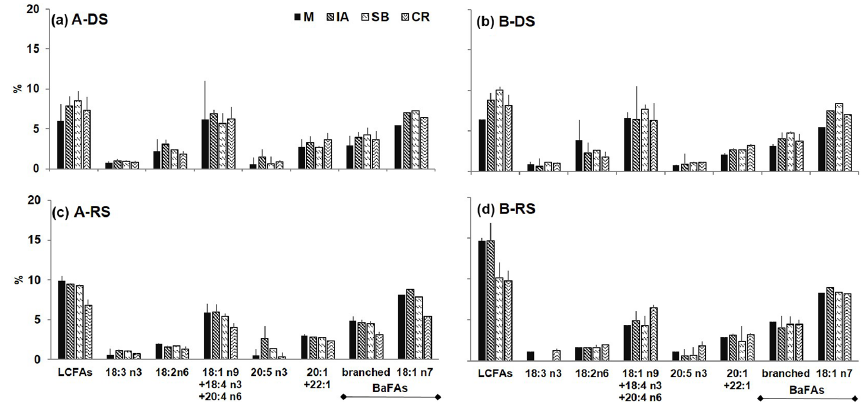
Figure 7. Mean ( ± SD) relative abundance of biomarker FAs (% of total FAs) in SOM. Selected biomarkers include LCFAs, 18:3 n3 and 18:2 n6 for mangroves, 18:2 n6 and 18:3 n3 for seagrasses, 18:2 n6 for agricultural runoff, 18:1 n9 + 18:4 n3 + 20:4 n6 for brown macroalgae, 20:5 n3 for red macroalgae and diatoms, 20:1 + 22:1 for zooplankton, branched FA, and 18:1 n7 for